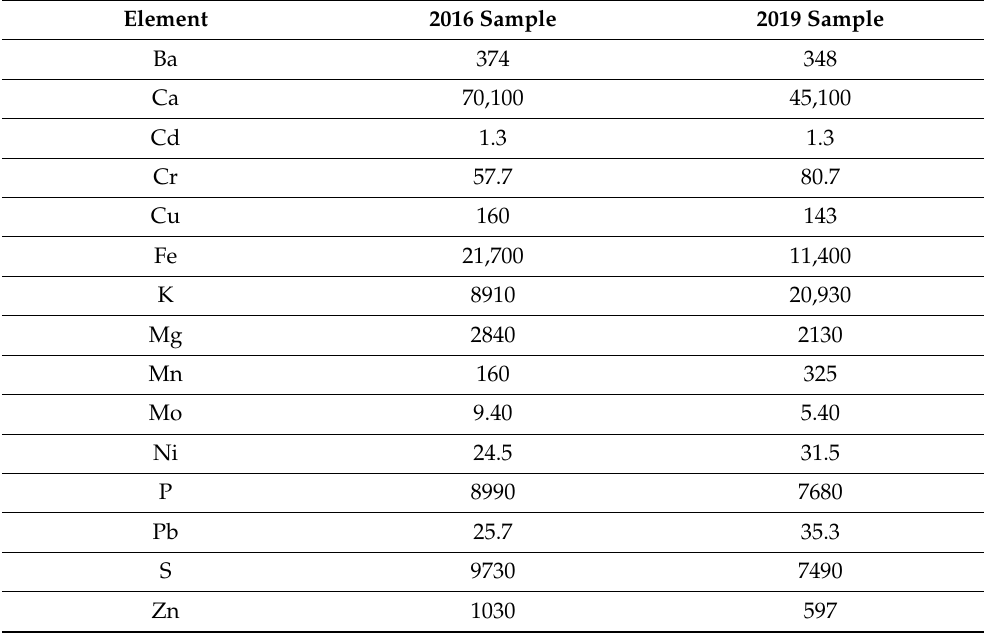
Table 1. Concentrations of elements (mg kg − 1 ) in alkaline biosolids samples collected in 2016 and